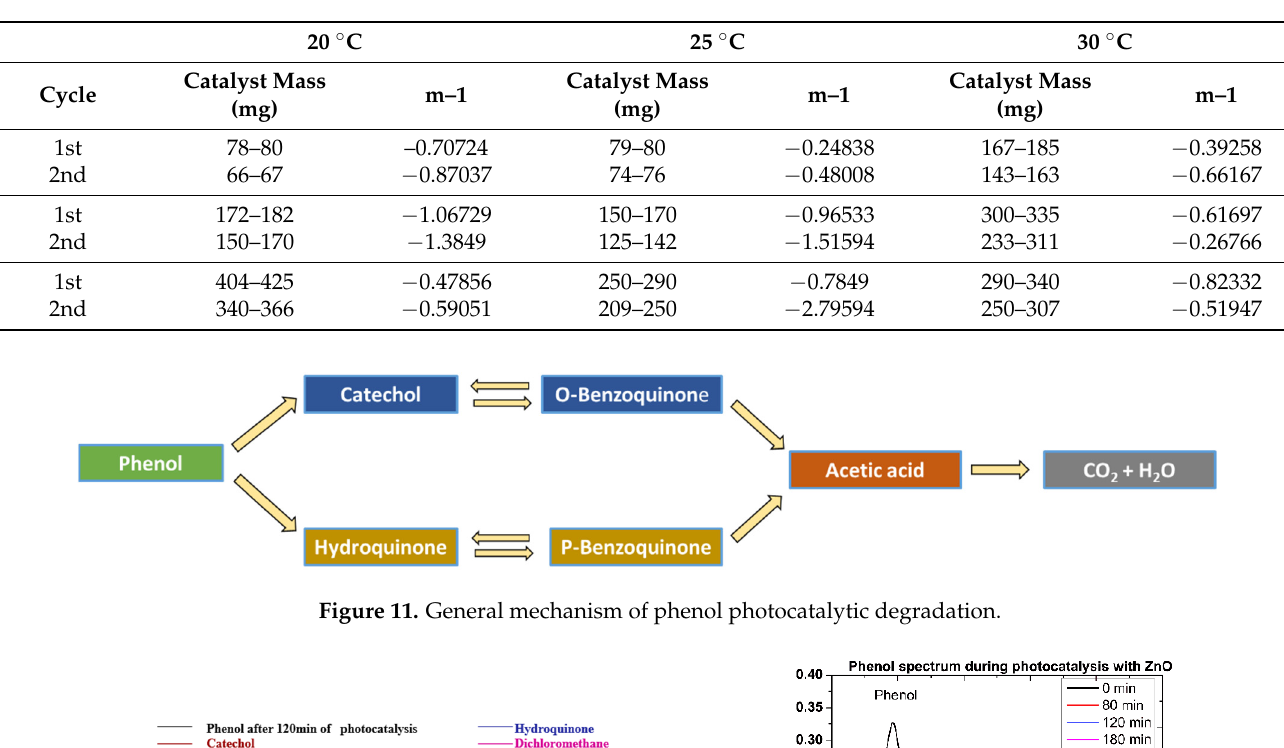
Figure 10. Plots of the apparent first order rate constant vs. the initial phenol concentration at tem- perature ( a ) 20 °C ( c ) 25 °C ( e ) 30 °C. Plots of the apparent first order kinetic constants vs. the ratio M at temperature ( b ) 20 °C ( d ) 25 °C ( f ) 30 °C. Table 4. Summary of the slopes obtained from linear regression analysis of batch tests.